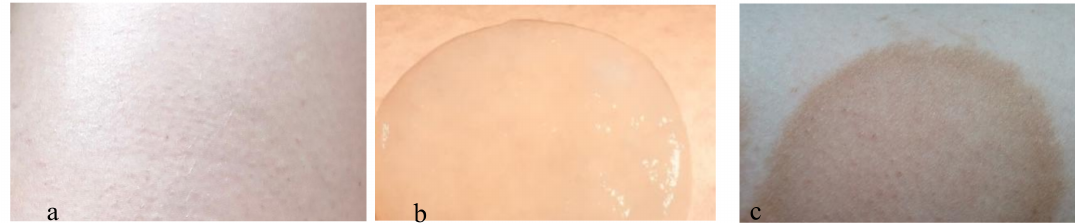
Figure 6. Skin area before ( a ), during ( b ) and after the application of MC with DHA ( c ) presents visible peripheral accentuation. Scale 1:2, 1 cm = 0.5